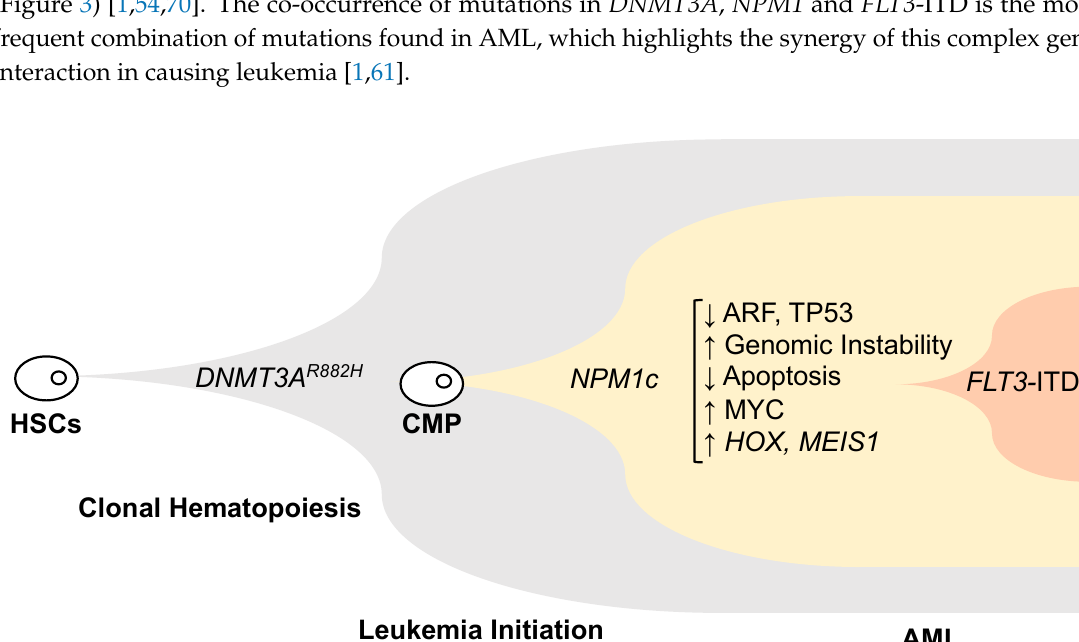
Figure 3. Mechanisms of leukemogenesis in AML with mutated NPM1 gene. NPM1 mutations alone are not sufficient for causing leukemia. They arise from common progenitor cells (CMP) that have expanded following clonal hematopoiesis. This figure shows the most common combination of mutations, but other mutations causing clonal hematopoiesis could provide a similar background. NPM1 mutations are leukemia-initiating. They disrupt multiple mechanisms with a specific dependence on HOX genes and their DNA-binding cofactor MIES1.